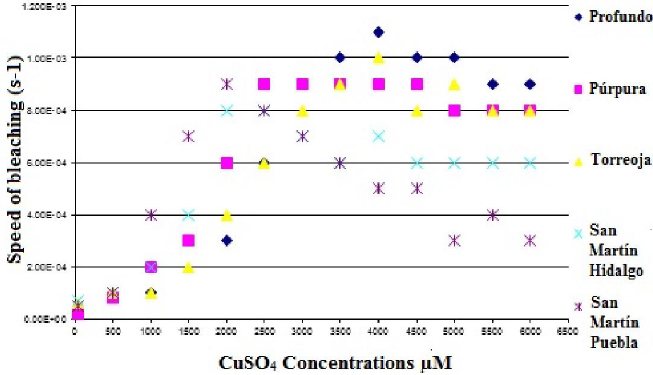
concentration. 4